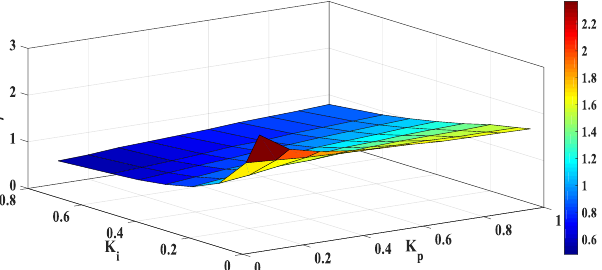
M = 0.5. 0.4  = and 0 . 5 M  = . Figure 9. Maximum permitted delay for an EV aggregator with α 1 = 0.4 and τ 1 1 1